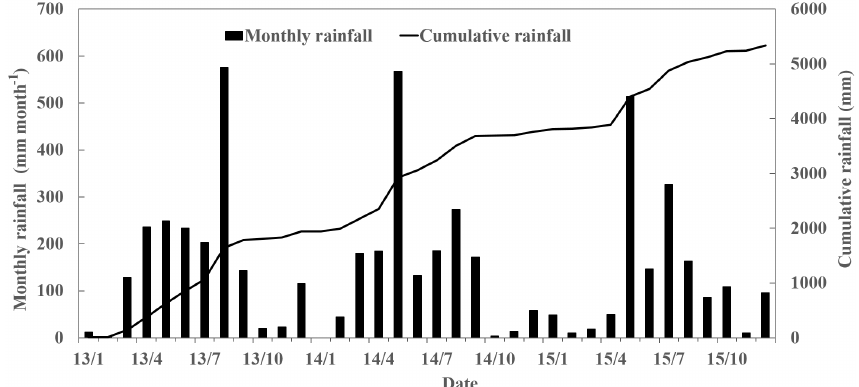
Figure 4. Monthly rainfall and cumulative precipitation between January 2013 and December 2015.